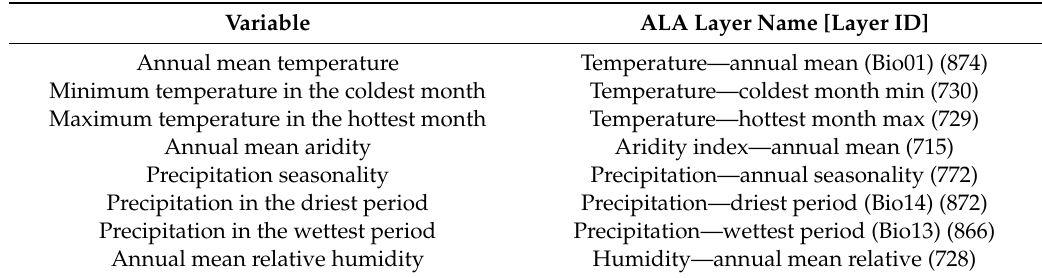
Table 1. Environmental data used in this study, as downloaded from the Atlas of Living Australia